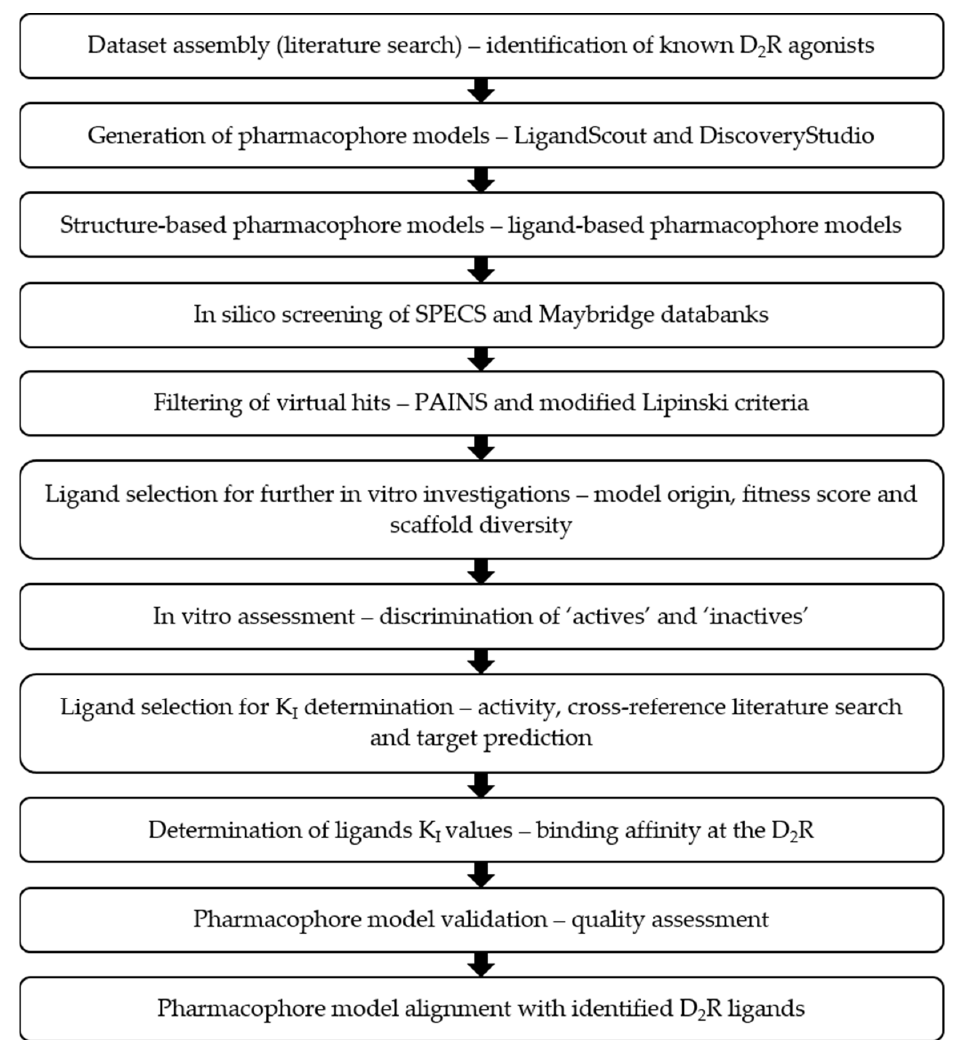
Figure 2. Combined in silico/in vitro approach to identify novel D 2 R ligands.